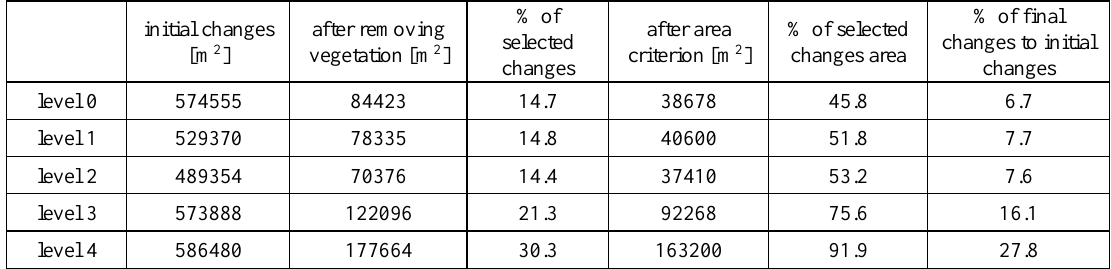
Table 2. The relationship between the image pyramid level and the matching processing time for test area